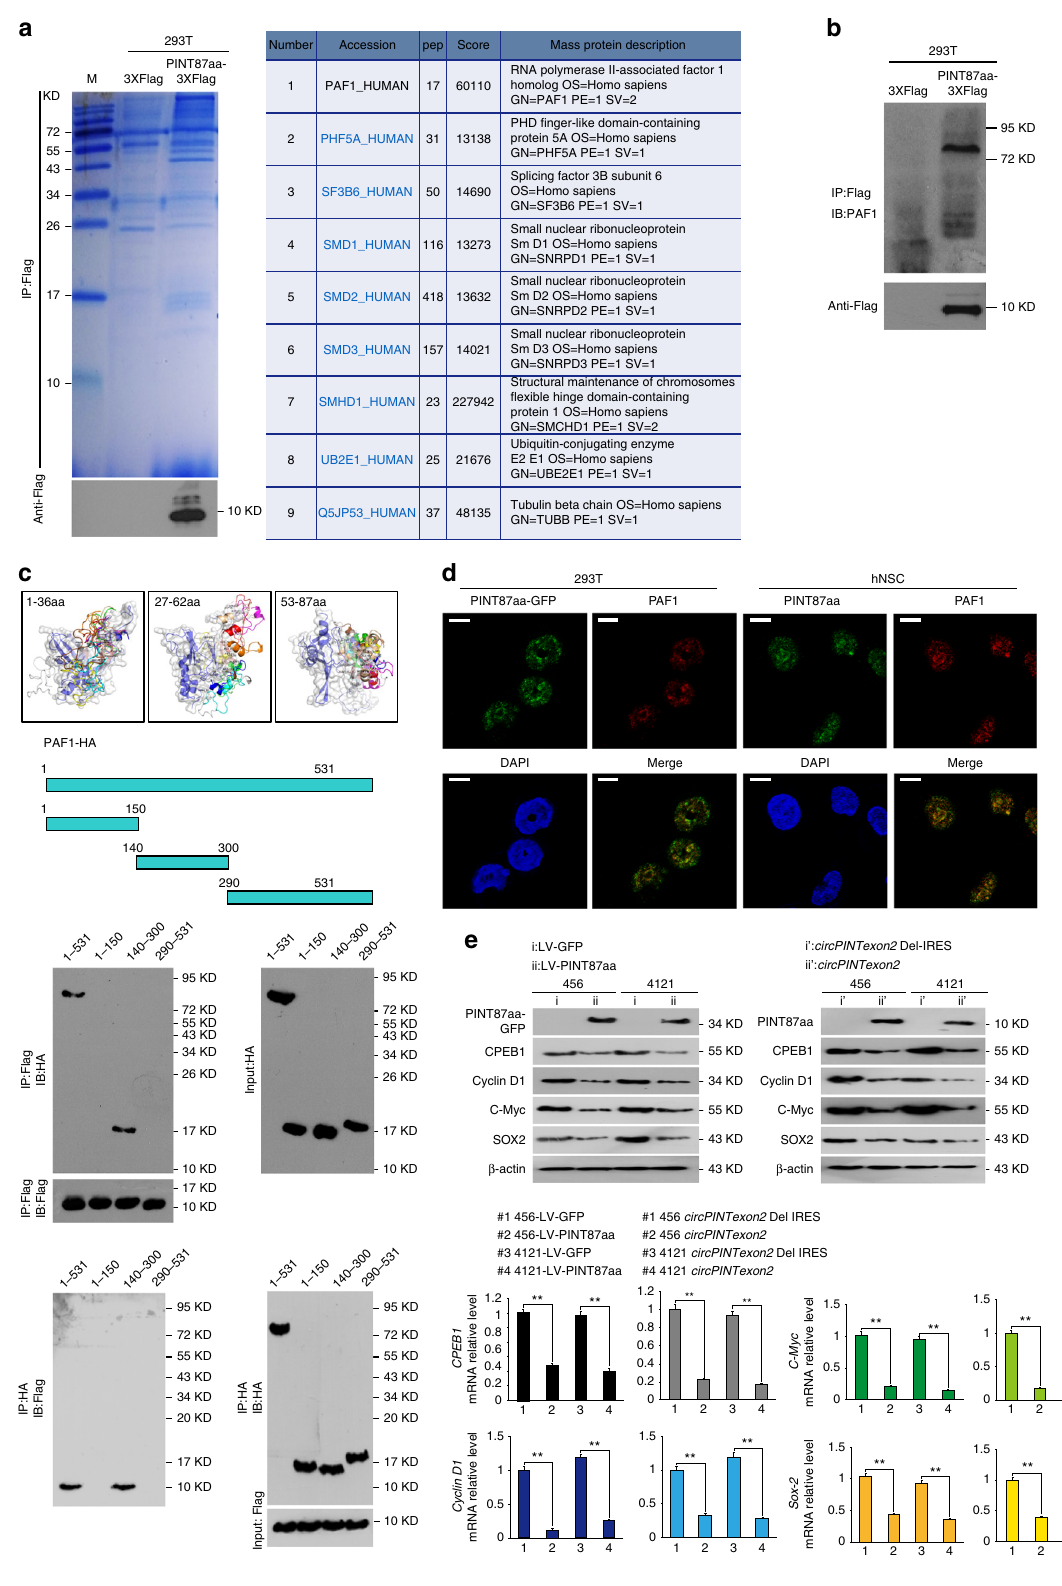
and PAF1, PINT87aa conformations were modeled with PEP- FOLD and docked to PAF1 based on the ATTRACT2 force fi eld through the PEP-SiteFinder pipeline 45 . Because PINT87aa was too long, it was split into three sections: 1 – 36 aa, 27 – 62 aa, and